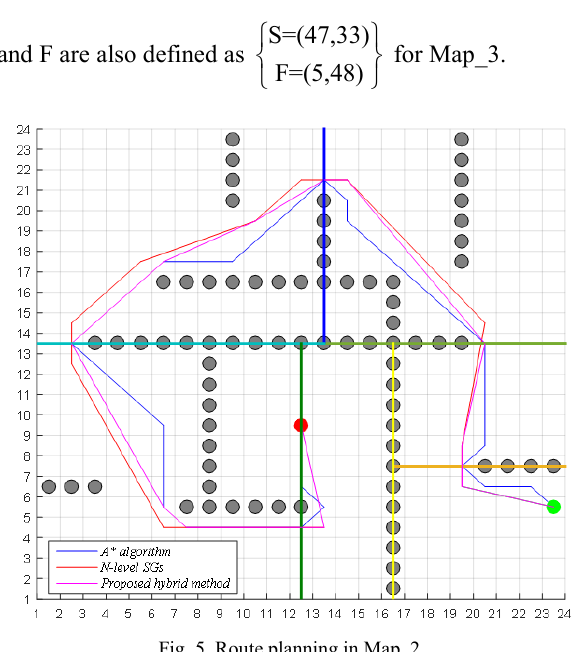
Fig. 5. Route planning in